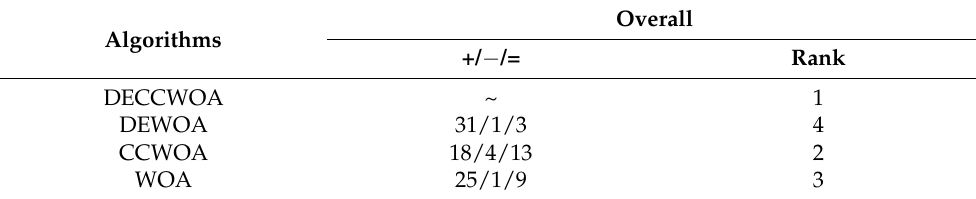
Table 4. Comparison results for the introduced